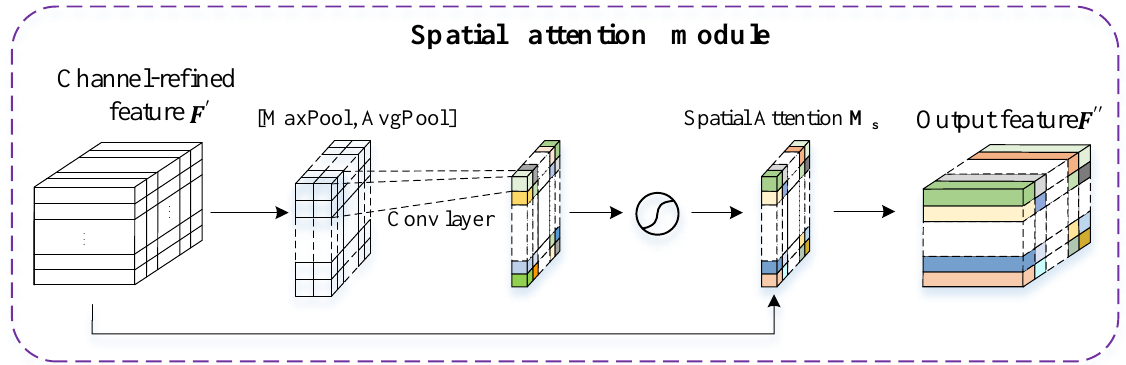
Figure 4. Schematic diagram of the spatial attention module.